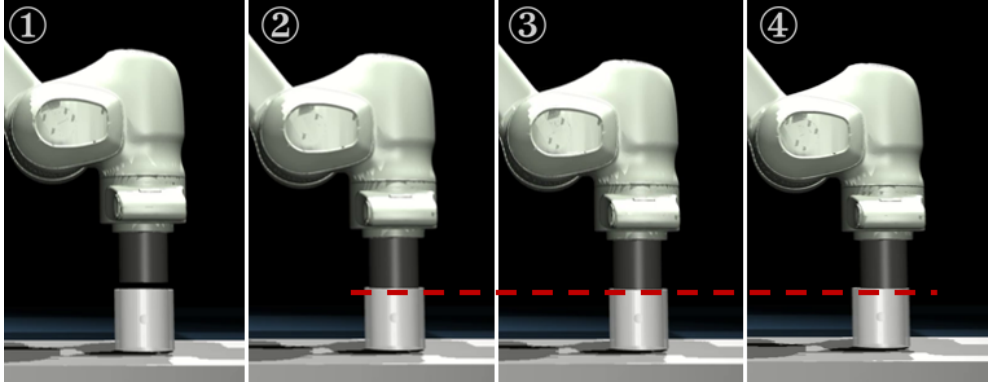
Figure 9. Snapshot of peg-in-hole scenario for MuJoCo: the peg is pressed down to insert the peg into the hole ( 1 ), but MuJoCo does not support nonconvex meshes, so peg cannot be inserted even if we keep pressing down ( 2 – 4